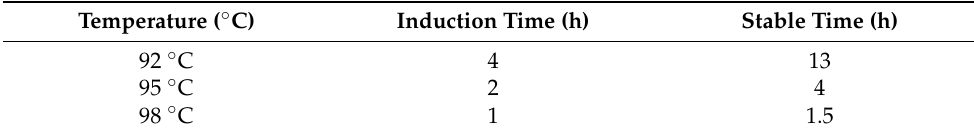
Table 1. Inductionandstabletimesof α